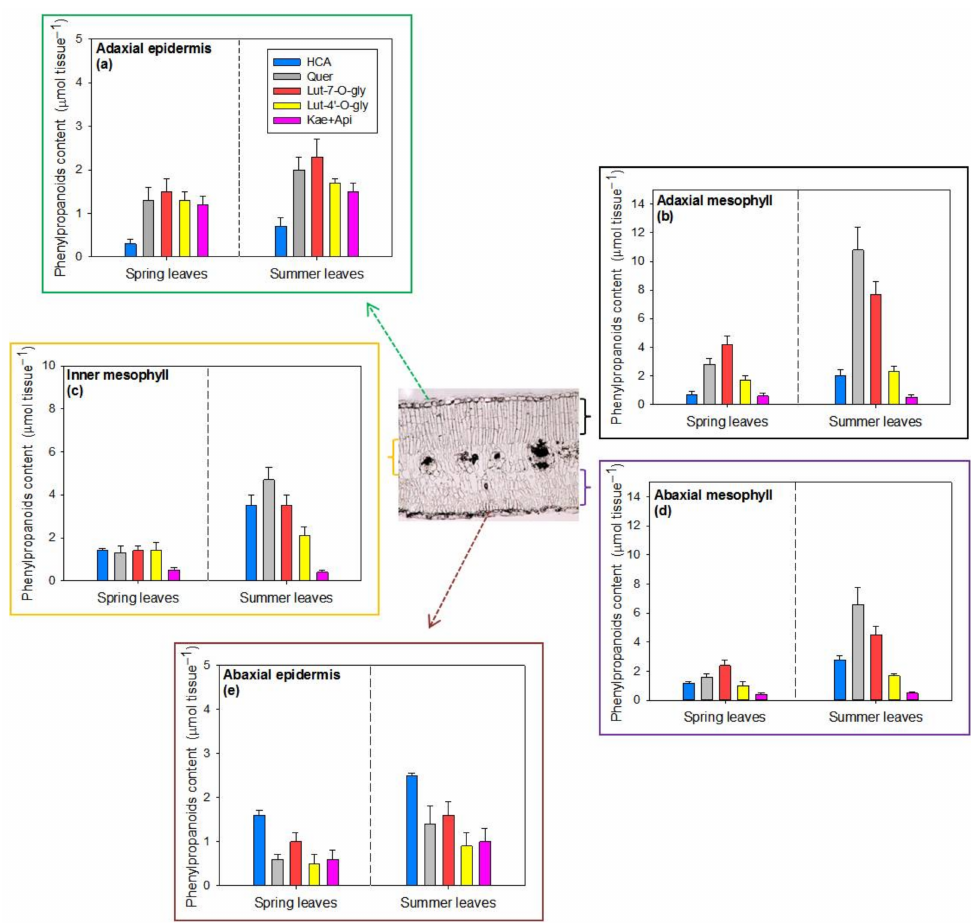
Figure 6. Content of phenylpropanoids ( µ mol tissue − 1 ) in different tissues (different colored rect- angles: ( a ), adaxial epidermis; ( b ), adaxial mesophyll; ( c ), inner mesophyll; ( d ), abaxial mesophyll; ( e ), abaxial epidermis) of spring (left-hand bars) and summer (right-hand bars) leaves of P. latifolia . Leaves were sampled during the central hours of the day (12:00–14:00 h) in spring (10–11 and 25–26 May) and summer (4–5 and 22–23 July). Analyses were conducted on two replicates for each sampling date, each replicate consisting of 4–5 leaves. The concentration of metabolites ( µ mol g − 1 DW) was multiplied by the DW of each tissue layer to calculate the tissue phenylpropanoid content ( µ mol tissue − 1 ). Data are reported as means ± SD ( n =